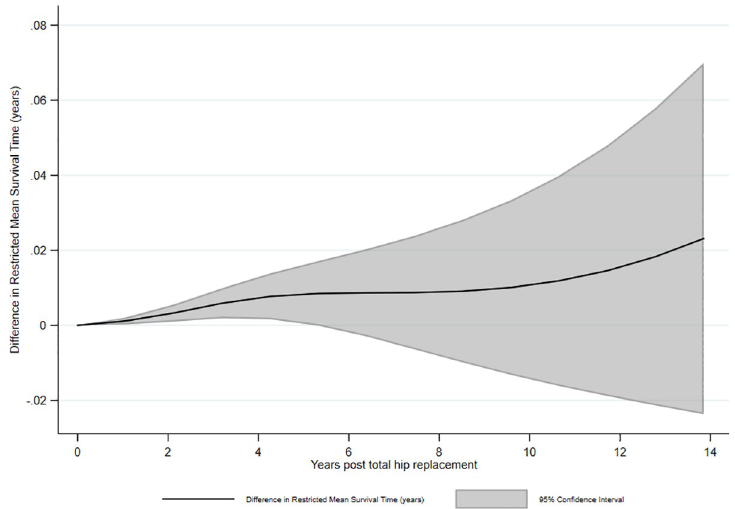
Fig 4. Difference in RMST between total hip replacements performed at the RD&E and in all other hospitals combined when using the same implants as those used at the RD&E. A demonstration of how the difference in RMST varies between the 2 exposure groups using the flexible parametric model adjusted for age, sex, and American Society of Anesthesiologists score and allowing for time varying effects. RMST, restricted mean survival time; RD&E, Royal Devon &